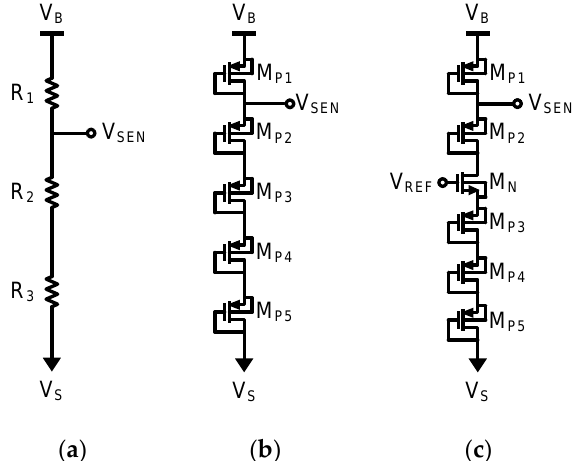
Figure 3. Supply-voltage sensor. ( a ) Resistive divider. ( b ) MOS-diode divider. ( c ) Proposed MOS-diode divider with a voltage limiter.